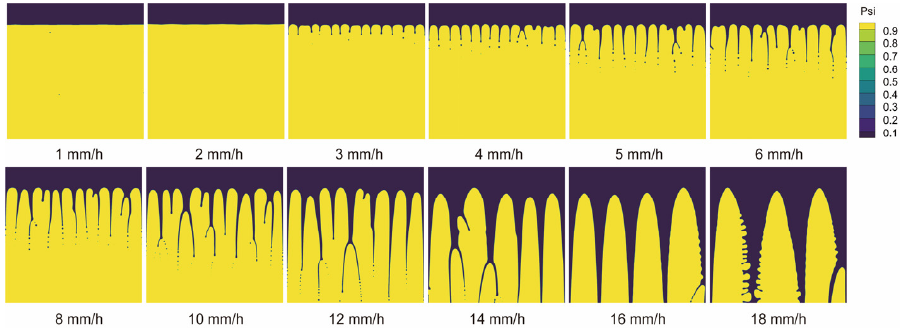
Figure 8. Microstructure growth simulation of bismuth telluride crystals at different melting furnace moving velocities.